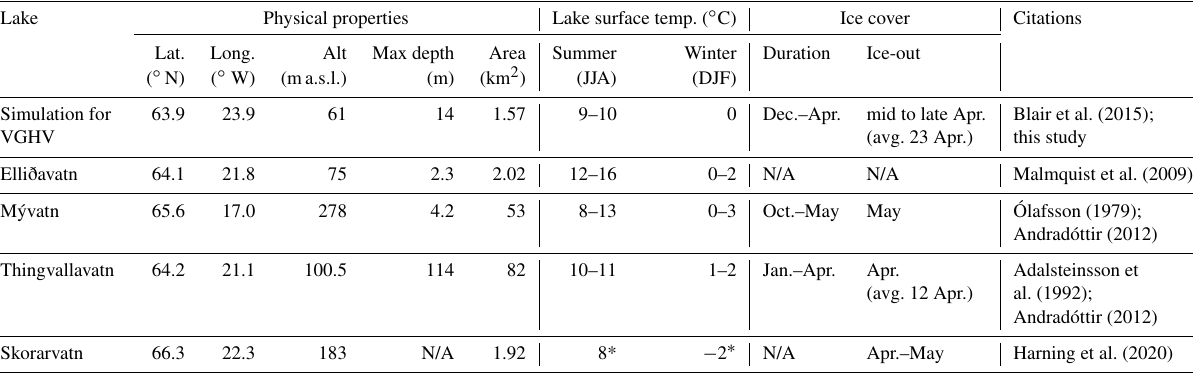
Table A2. Outputs for lake model simulation and comparison with available observational data from Iceland (where N/A means not avail- able).